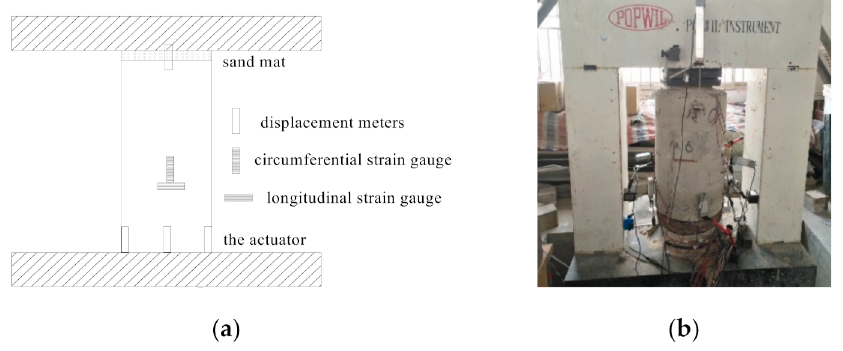
Figure 3. The placement of displacement meters and strain gages. ( a ) Design positions of meters; ( b ) Actual positions of meters.